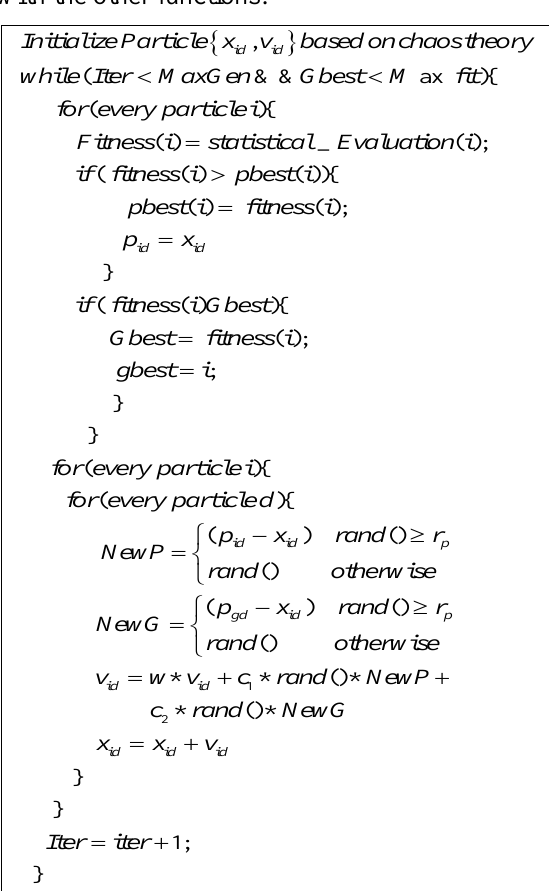
Figure 4. Pseudo-code of the chaotic-based PSO algorithm.